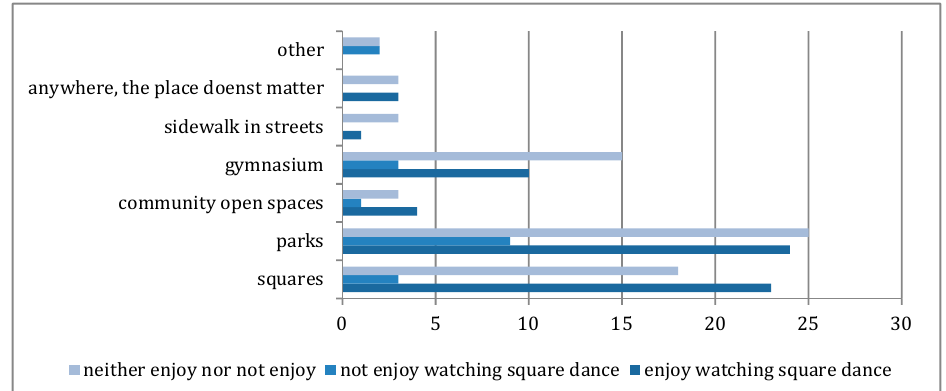
Figure 5. Participants’ responses for appropriate places for practicing square dancing and their preferences of watching square dancing.